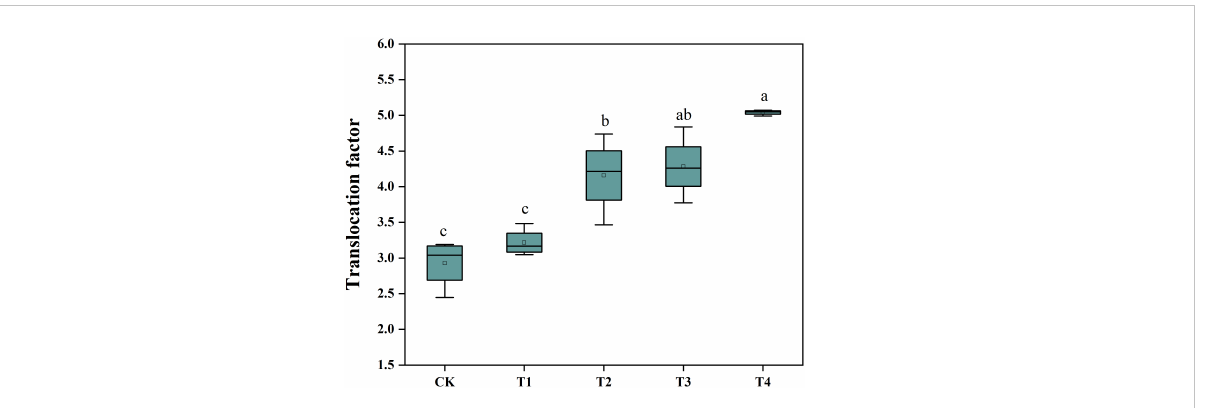
FIGURE 3 The Cd translocation factor of S. alfredii . CK: control treatment, T1, T2, T3 and T4 were the Si concentrations of 0.5, 1.0, 1.5 and 2.0 mmol ∙ L -1 , respectively. Values are mean ± SD and columns denoted with different letters indicate signi fi cant difference among treatments at P < 0.05.